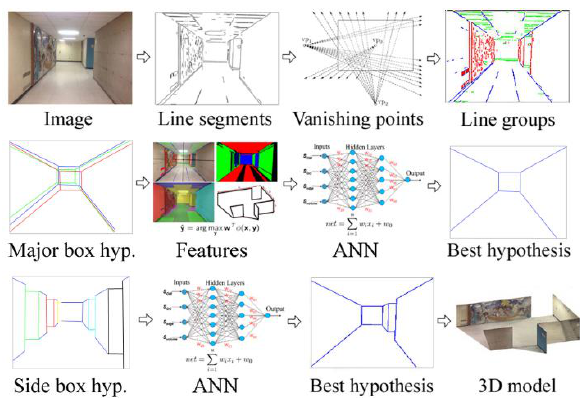
Figure 2. The proposed method extracts straight line segments and estimates orthogonal vanishing points. This method creates